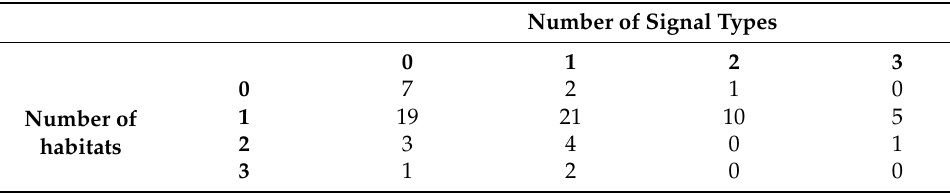
Table 2. The number of heteropteran families found to exhibit 0, 1, 2 or 3 signal types and found in 0, 1, 2 or 3 habitat types. Lack of reporting and limited study of many families will influence current estimates of signal and habitat diversity across the